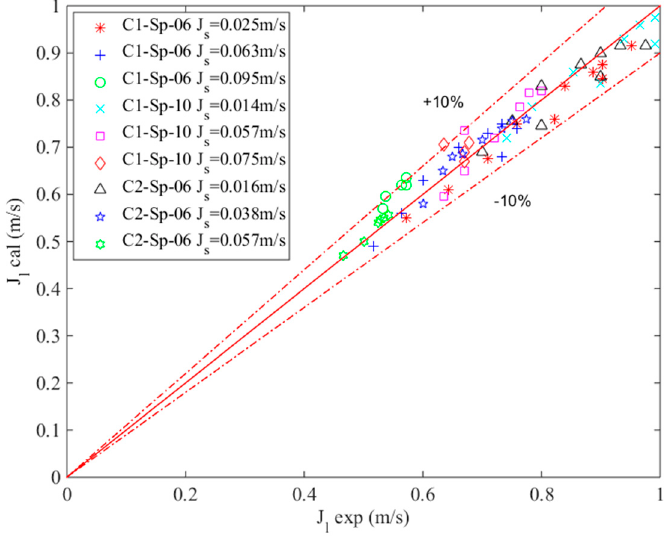
Figure 2. Validation results by experimental data from Yoshinaga and Sato [6].